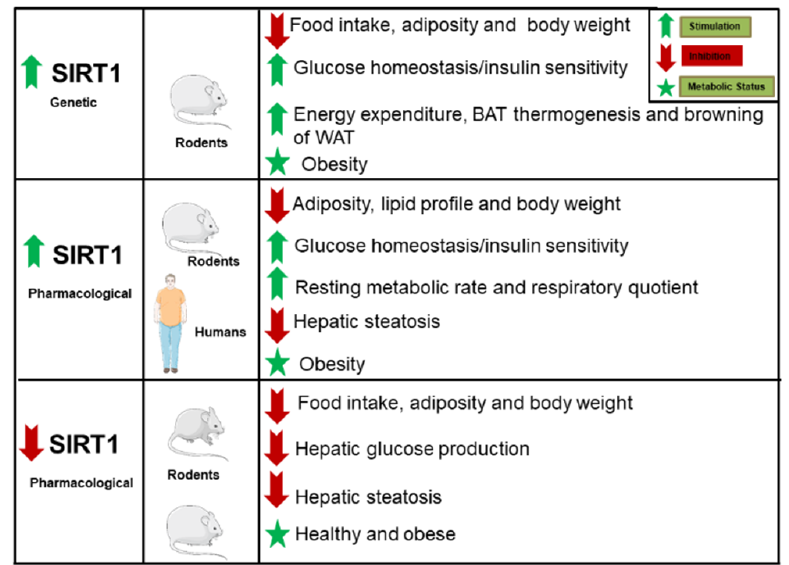
Figure 1. Description of the metabolic actions elicited by SIRT1 in mice and humans. Pharmacological or genetic modulation of SIRT1 regulates body weight, adiposity in WAT and liver, food intake, energy expenditure, resting metabolic rate, respiratory quotient, BAT thermogenesis, browning of WAT, glucose homeostasis and insulin sensitivity. green arrow: stimulation, red arrow: inhibition, green star:metabolic state. Abbreviations used-BAT; brown adipose tissue; SIRT1: sirtuin 1; WAT; white adipose tissue. The figures were generated by using materials from Servier Medical Art (Servier) under consideration of a Creative Commons Attribution 3.0 Unported License. With regard to genetic animal models for SIRT1, the global knock out (KO) mice for SIRT1 are not viable or have several metabolic complications [30], whereas moderate overexpression of SIRT1 in mice improves several metabolic parameters associated with obesity [31] (Figure 1). Consistently, the pharmacological activation of SIRT1 produces a variety of beneficial metabolic actions in vivo (Figure 1). In this sense, natural activators of SIRT1, such as the polyphenol resveratrol (RSV) [32,33] or synthetic molecules [34–36], have been used for this purpose. These pharmacological activators improve insulin sensitivity, increase insulin secretion, enhance mitochondrial function, decrease adiposity and lower glucose levels [37–41]. Intriguingly, a negative energy balance was also observed in mice following pharmacological inhibition of SIRT1 [26,27]. Therefore, a controversy